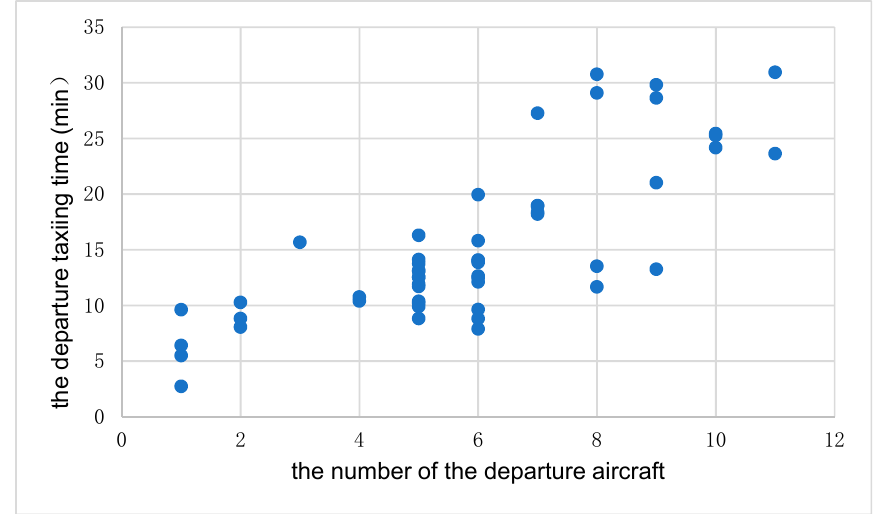
Figure 5. The scatter diagram of the relationship between the departure taxiing time and the number of departing aircraft.